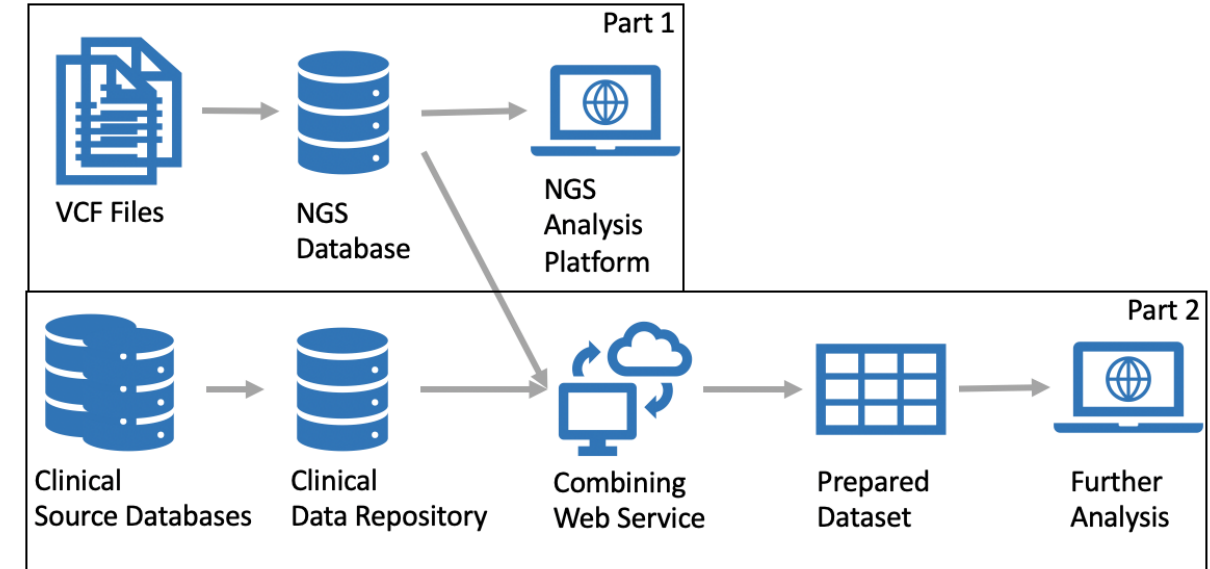
Figure 1. Genomics pipeline and analysis system. NGS: next-generation sequencing; VCF: variant call